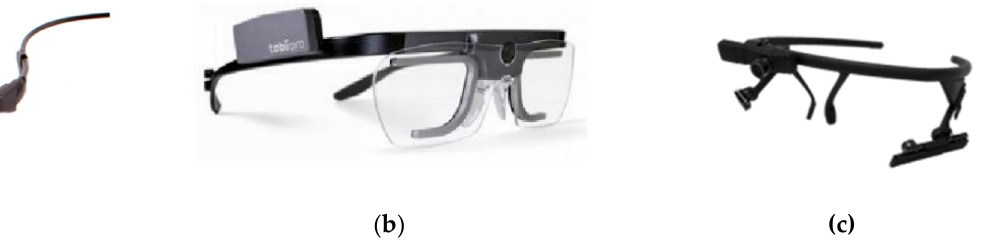
Figure 2. Commercial head-mounted eye-trackers: ( a ) Dikablis Glass 3.0 [126]; ( b ) Tobii Glass 2 [127]; ( c ) Pupil Labs Glasses [128]. ( c ) Pupil Labs Glasses [128].